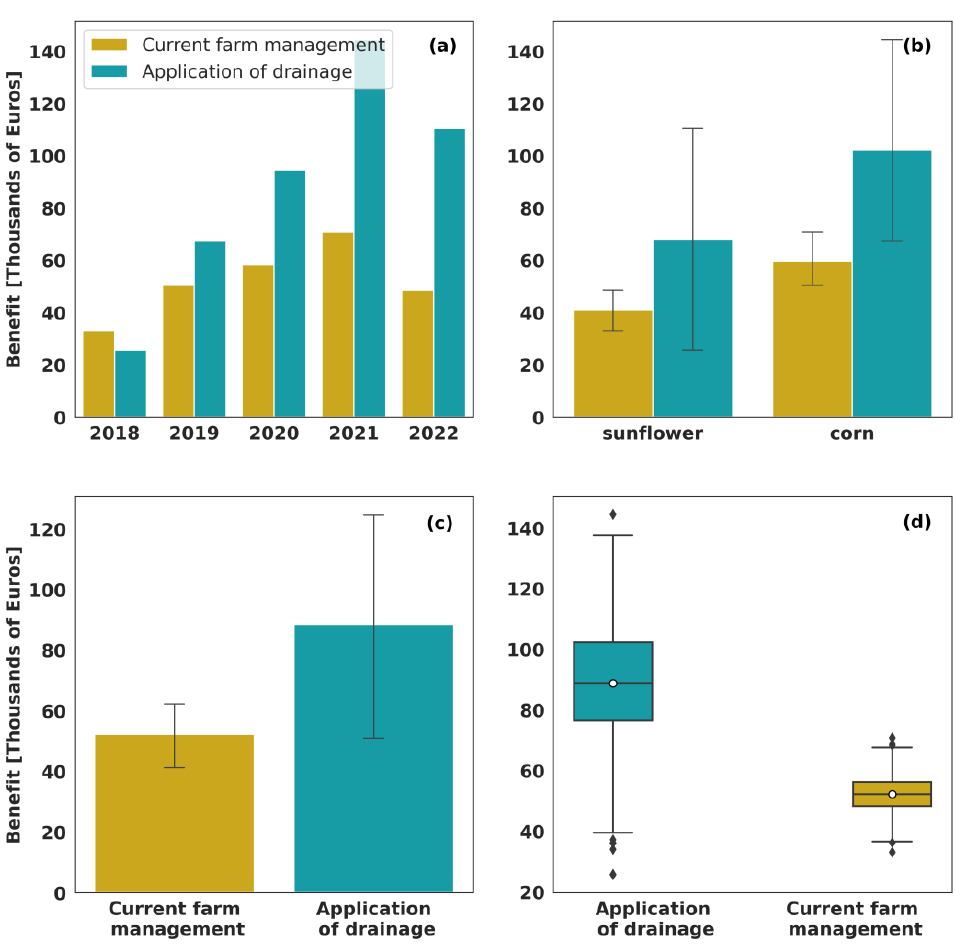
Figure 3. Distribution of farm income as a benefit, presented in Hungarian forint (local currency). ( a ) Data presented per year from 2018 to 2022 for the current farm management scenario (i.e., in the absence of drainage application) and the expected scenario (i.e., if drainage is applied), ( b ) data grouped per crop type, ( c ) the overall difference (mean ± sd) between the actual and the expected benefit after drainage, and ( d ) the distribution of actual and estimated benefit after drainage application. In panels ( c , d ), data is based on 10,000 simulations conducted using the A/B test. The white dots in the boxplot represent the average benefit over a period of four years. The points in diamond shape outside the lower and upper whiskers of the boxplot indicate possible outliers as a result of multiple simulations.